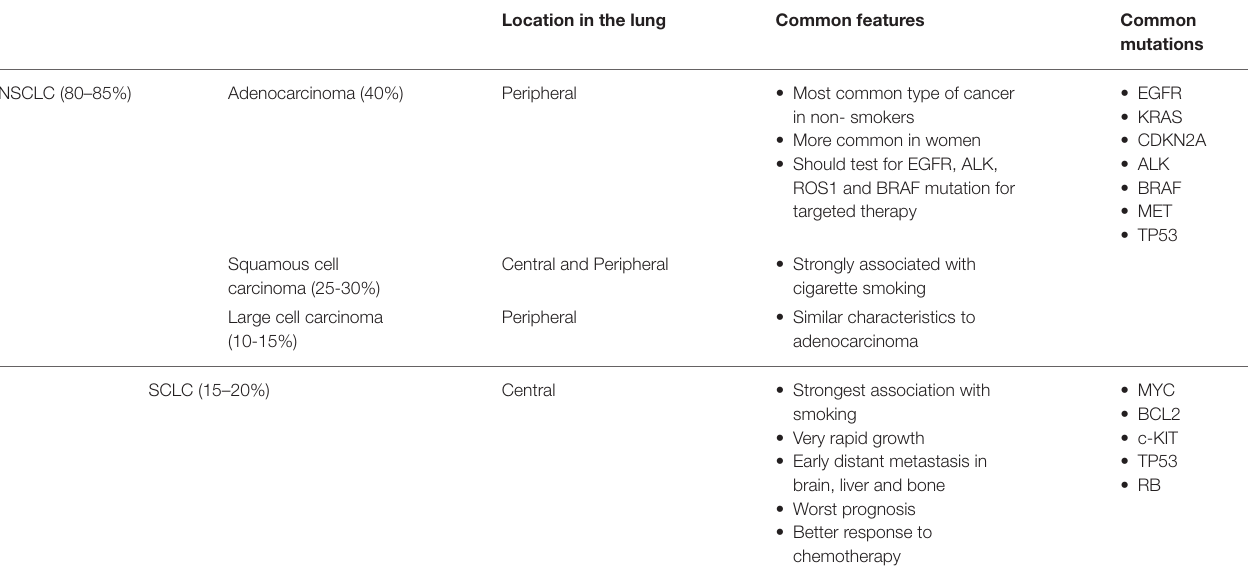
TABLE 1 | Lung cancer